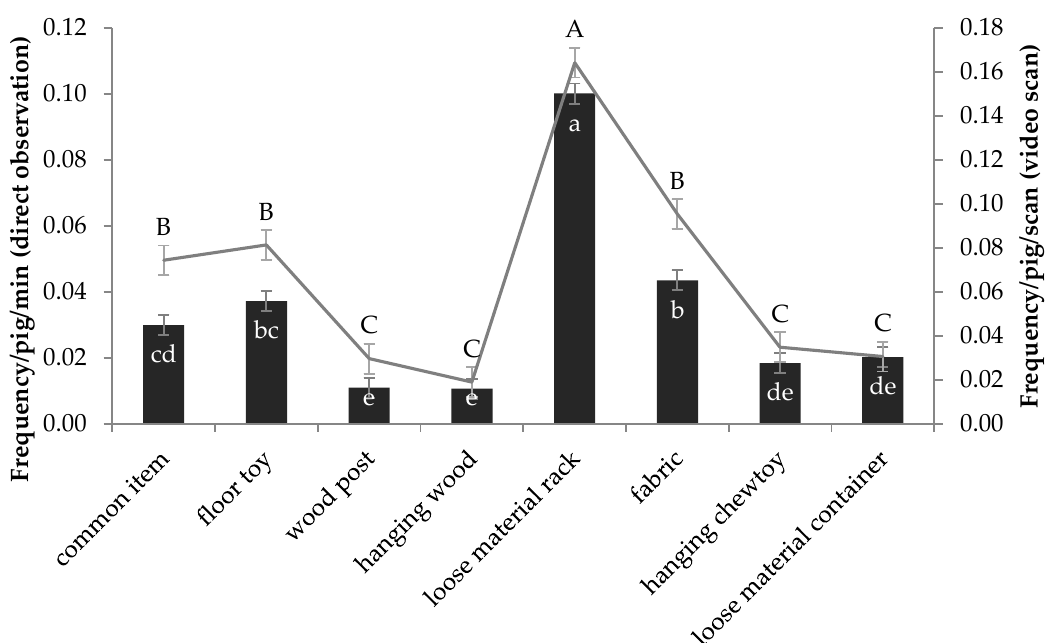
Figure 2. The overall pig interaction frequency with each category of enrichment at a pen level (n = 8) via direct observation (bar chart, different small letters denote significant difference) and video scans (line chart, different capital letters denote significant difference). The data are presented as the mean ± S.E.